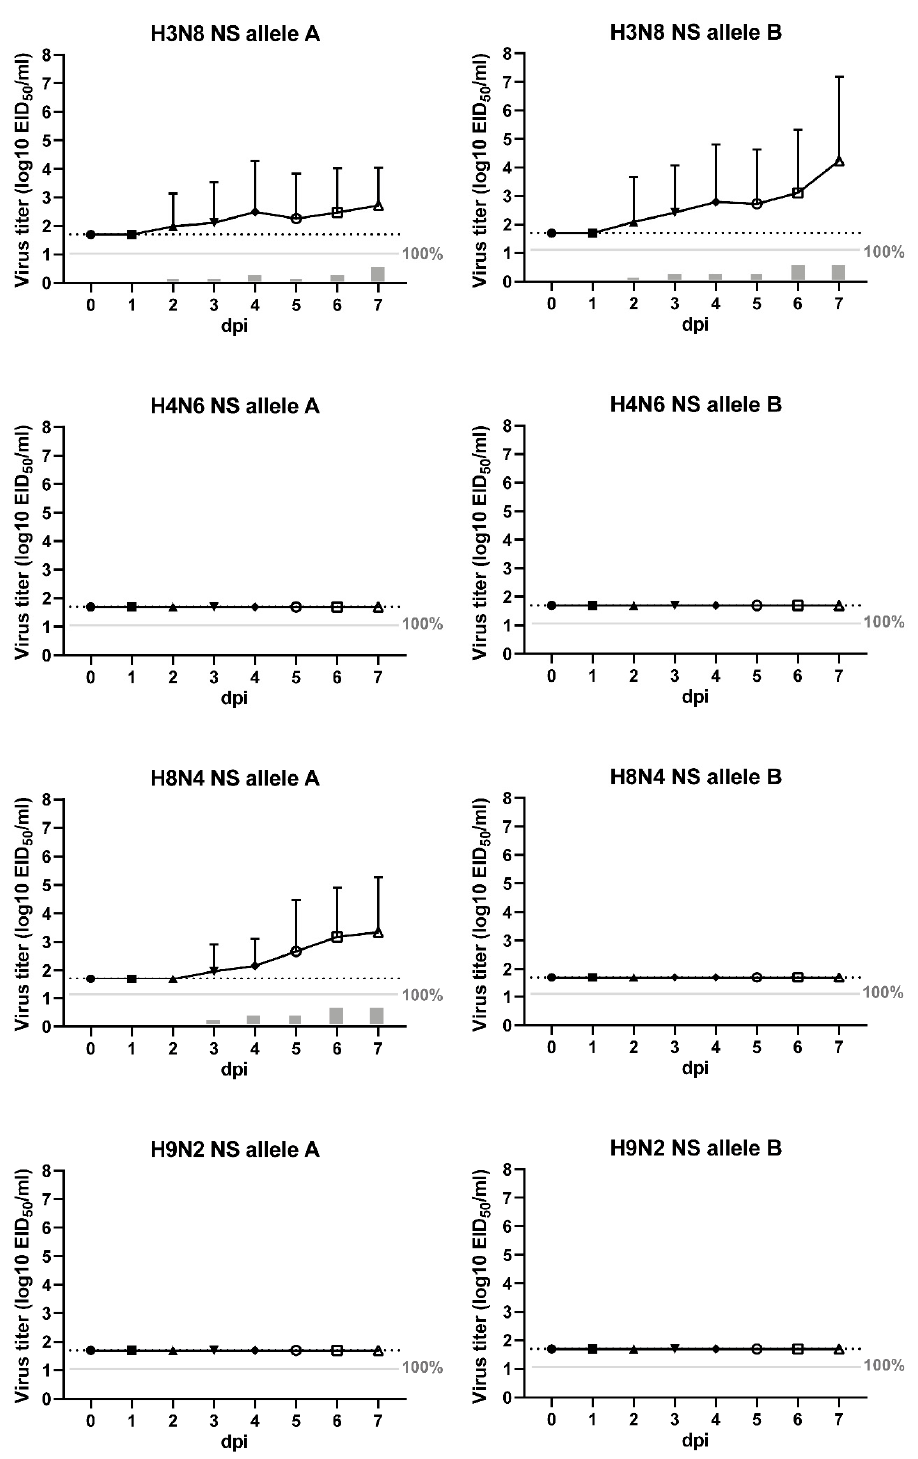
Figure 3. Cloacal shedding. Virus detected in cloacal (CL) swabs collected from chickens inoculated by the intranasal (IN) and intratracheal (IT) route with eight strains of low pathogenic avian influenza (LPAI) viruses (10 5.3 median egg infectious dose (EID 50 ) per bird). The swabs were taken daily from live birds to seven days post inoculation (dpi) for virus detection by influenza virus-specific PCR (M-PCR). Viral shedding is expressed as the mean equivalent log10 EID 50 / mL titre ± standard deviation (SD) with a lower detection limit of 10 1.7 EID 50 / mL (dashed line). The grey bars below the solid line indicate the percentage of positive swabs.